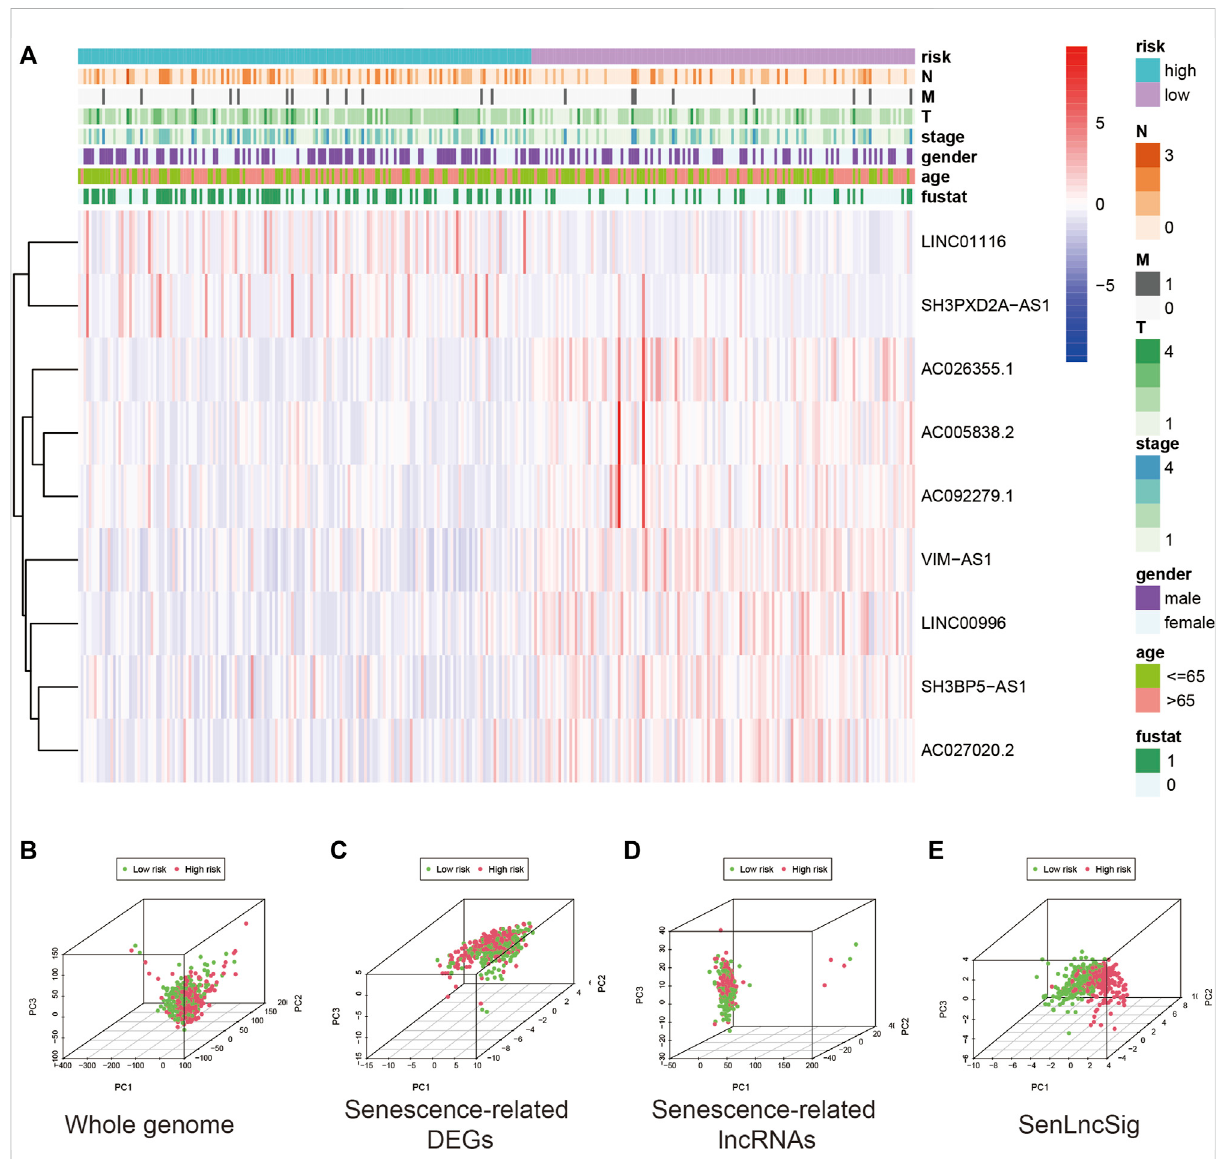
FIGURE 5 Expression levels of the nine lncRNAs based on clinicopathological variable strati fi cation and PCA of the different gene sets used to classify patients into different risk groups. (A) Nine senescence-related lncRNAs and clinicopathological variables were distributed as a heat map for the high- and low-risk groups. PCA based on (B) whole-genome mRNA transcripts, (C) senescence-related mRNAs (D) senescence-related lncRNAs, and (E) riskmodelincludingthenineLUADSenLncSigsenescence-relatedlncRNAs.Patientswithhigh-riskscoresareshowninredandsubjects with low-risk scores are shown in green. LncRNAs, long non-coding RNAs; PCA, principal component analysis; LUAD, lung adenocarcinoma; LUADSenLncSig, LUAD senescence lncRNA signature; T, tumor; N, lymph node metastasis; M, distant